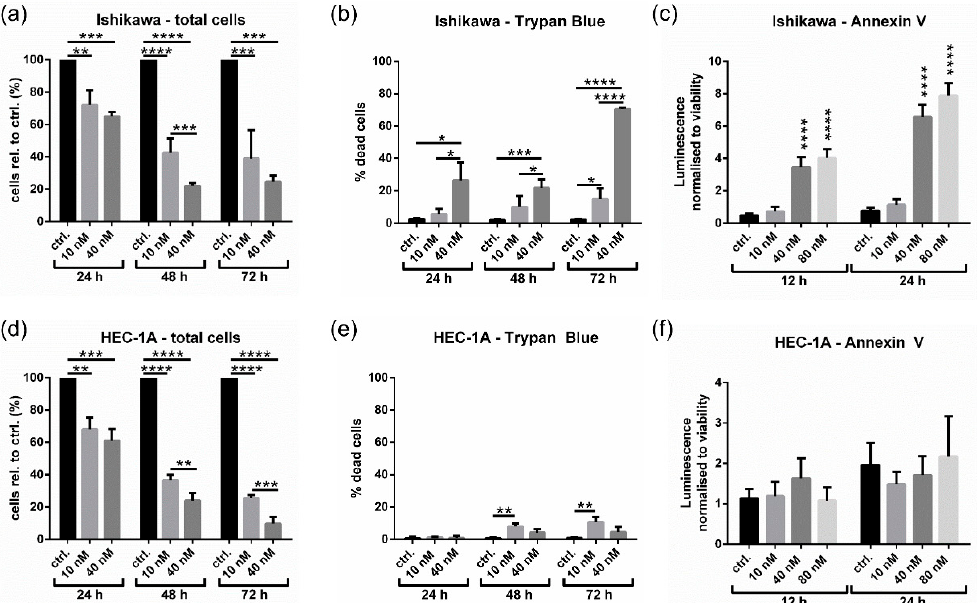
Figure 3. Dinaciclib shows potent anti-proliferative activity in Ishikawa and HEC-1A cells, and is cytotoxic in Ishikawa cells. Total cell numbers were counted using an automated cell counter in ( a ) Ishikawa and ( d ) HEC-1A samples following treatment with DMSO, or 10 or 40 nM dinaciclib for 24, 48, or 72 h. Trypan Blue was used to identify dead cells within total cell counts as shown in ( b ) and ( e ) for Ishikawa and HEC-1A cells, respectively. Cell numbers are expressed as a percentage of control values. Apoptosis in ( c ) Ishikawa and ( f ) HEC-1A samples was measured using the RealTime-Glo Annexin V Apoptosis and Necrosis Assay following 12 and 24 h of treatment with DMSO, or 10, 40, or 80 nM of dinaciclib. Statistical significance was calculated by ANOVA followed by Dunnett’s test. * p value < 0.05 , ** p value < 0.01, *** p value < 0.001, **** p value < 0.0001.